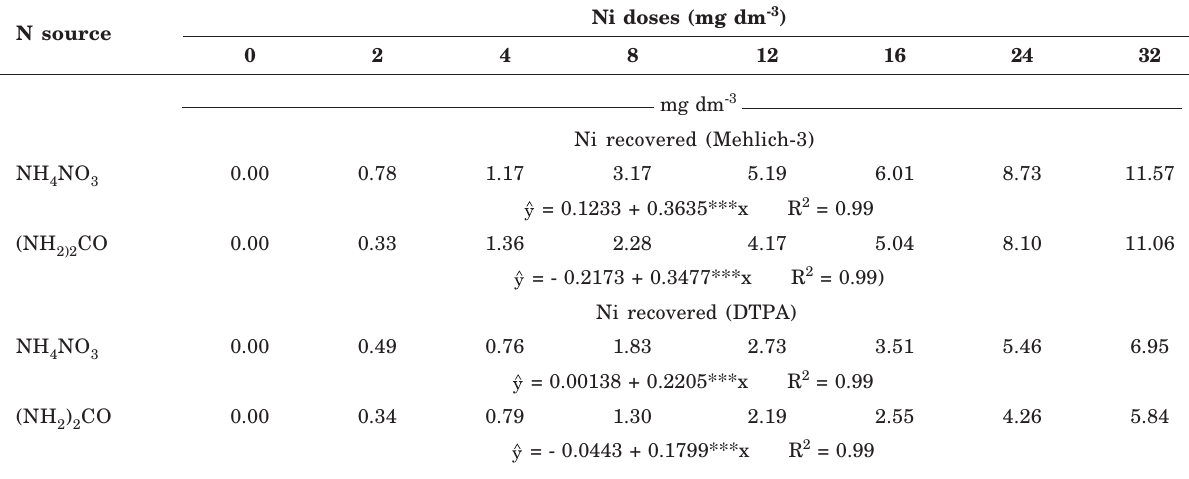
Table 4. Nickel concentrations in soil amended with Ni and fertilized with two N sources. Regression equations for the Ni recovered from the soil (Mehlich-3 and DTPA extractions) are a function of the Ni doses applied to the